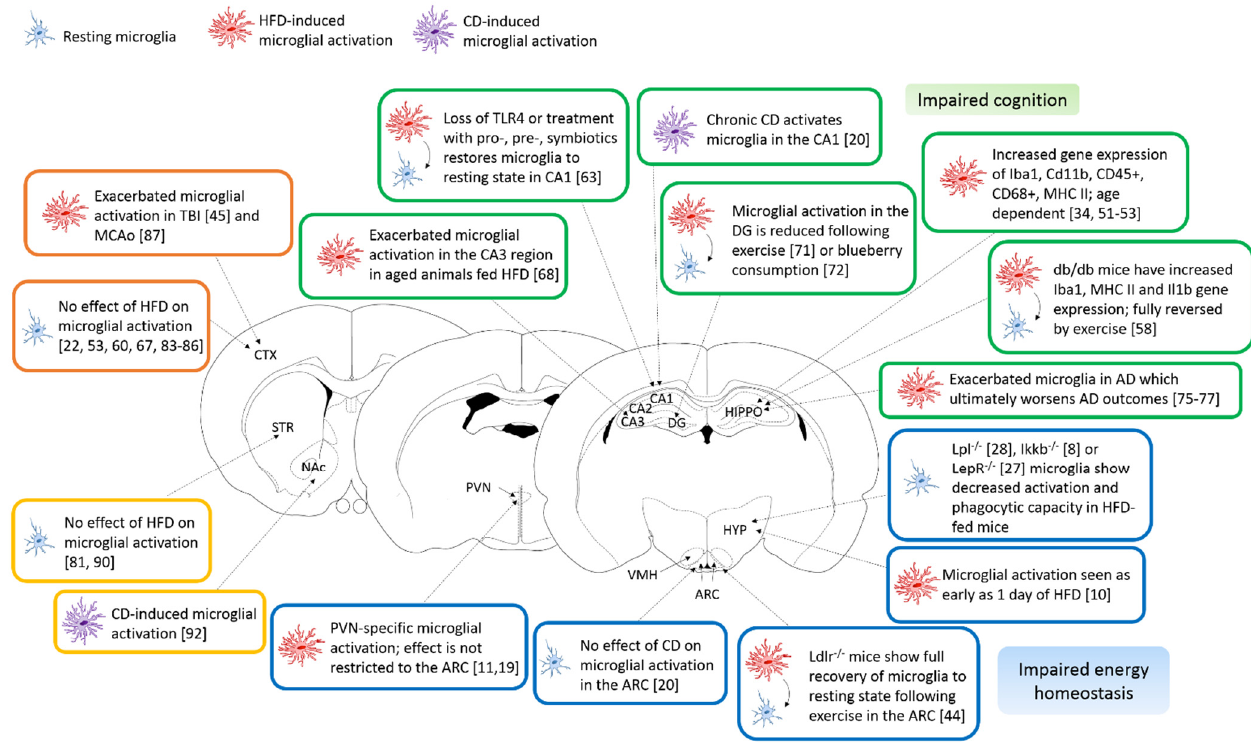
Figure 1. Microglial brain region heterogeneity in obesity. Schematic representation of the main findings of this review using mouse coronal brain slices to illustrate the regions of interest. Resting microglial cells are represented in blue, HFD-activated microglia in red and CD-activated microglia are in purple. The main findings for the hypothalamus are presented in the blue boxes, for the hippocampus, in green boxes, for the cortex, in orange boxes and, for the striatum, in the yellow boxes. Abbreviations: AD—Alzheimer’s Disease, ARC—Arcuate nucleus, CA1-3—Cornu Ammonis, CD—Cafeteria diet, CTX—Cerebral cortex, DG—Dentate gyrus, HFD—high-fat diet, HIPPO—hippocampus, HYP—hypothalamus, MCAo—Middle cerebral artery occlusion, NAc—Nucleus accumbens, PVN—Paraventricular nucleus, TBI—Traumatic brain injury and VMH—Ventromedial hypothalamic nucleus.